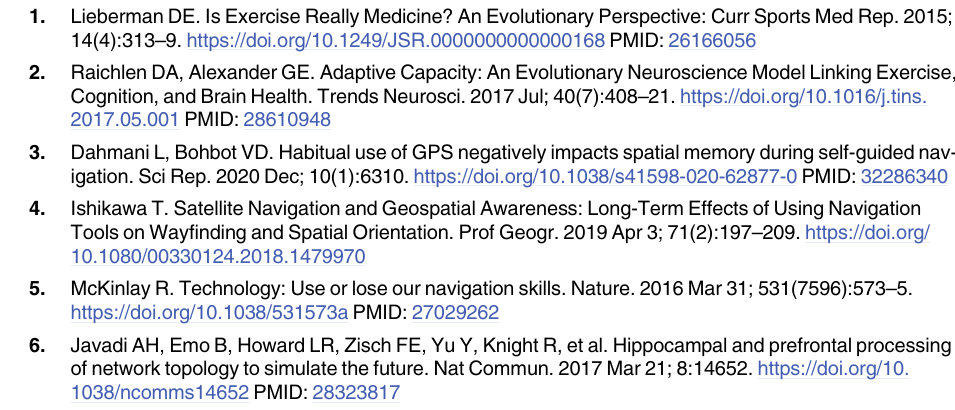
S1 Table. Summarized responses to the orienteering experience questionnaire. Bolded val- ues indicate largest percentage within